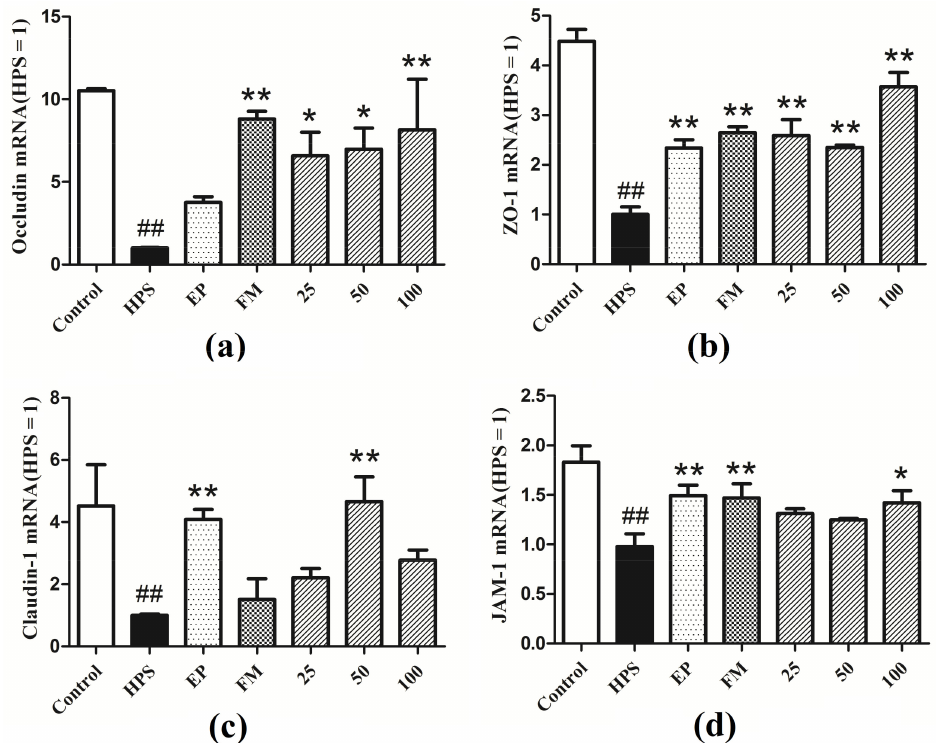
Figure 2. Expressions of tight junctions genes ( a ) Occludin, ( b ) ZO-1, ( c ) Claudin-1, ( d ) JAM-1 in the peritoneum of piglets challenged with G. parasuis (Mean ± SD, n = 3). HPS: G. parasuis group, EP:EP + G. parasuis group, FM:FM + G. parasuis group, 25:25 mg/kg baicalin + G. parasuis group, 50:50 mg/kg baicalin + G. parasuis group, 100:100 mg/kg baicalin + G. parasuis group. ## p < 0.01 vs control. * p < 0.05 vs G. parasuis group, and ** p < 0.01 vs G. parasuis